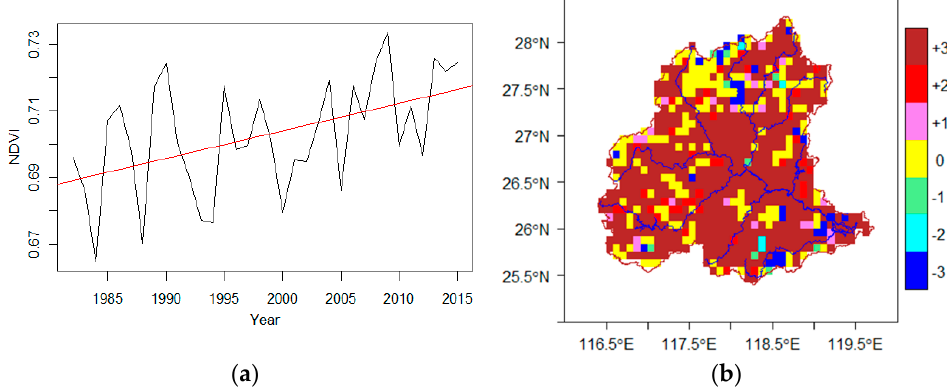
Figure 15. Changes of the annual areal average NDVI ( a ) and the trend of monthly NDVI ( b ) over the Min River basin during 1981 to 2015. (Note: the number +3, +2, +1, and 0 stand for very significant trend, significant trend, weak trend, and no trend, respectively, and the sign (+ or − ) stands for negative or positive trend.).